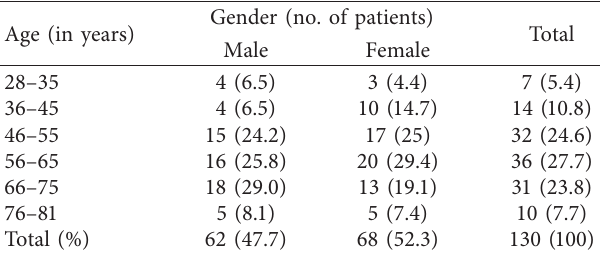
Table 1: Age and gender distribution of patients with SGC of the eyelid.